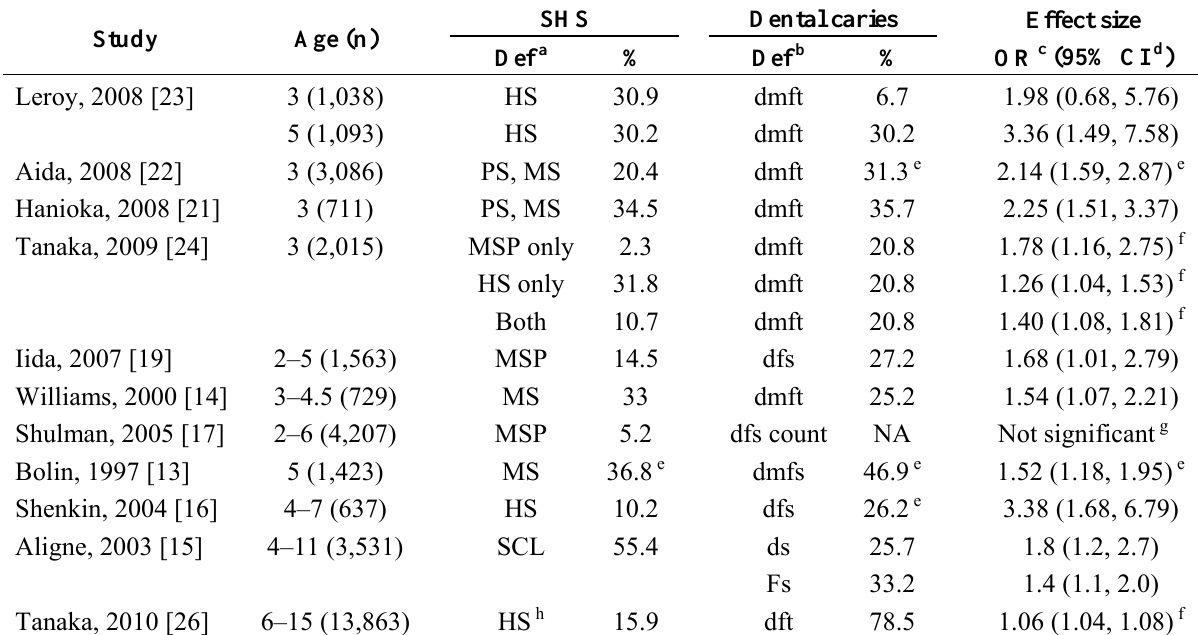
Table 3. Relationship between SHS exposure and caries of deciduous teeth sorted by age of children. Study